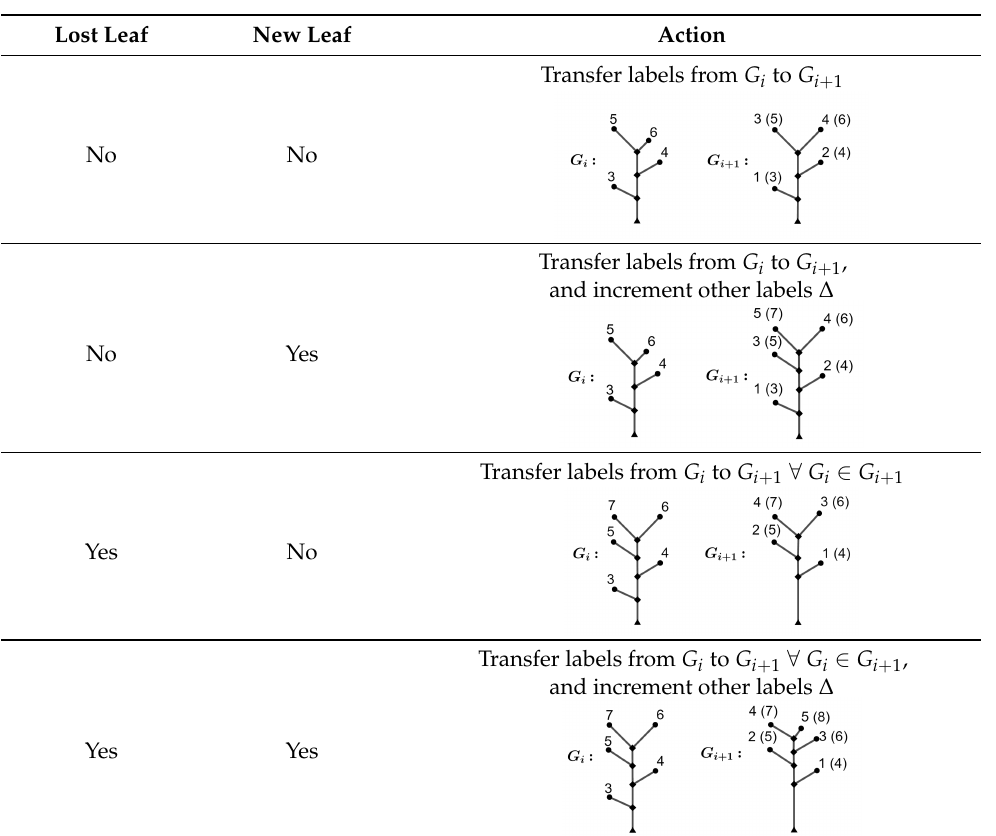
Table 1. Possible scenarios and corresponding actions for leaf tracking for two consecutive